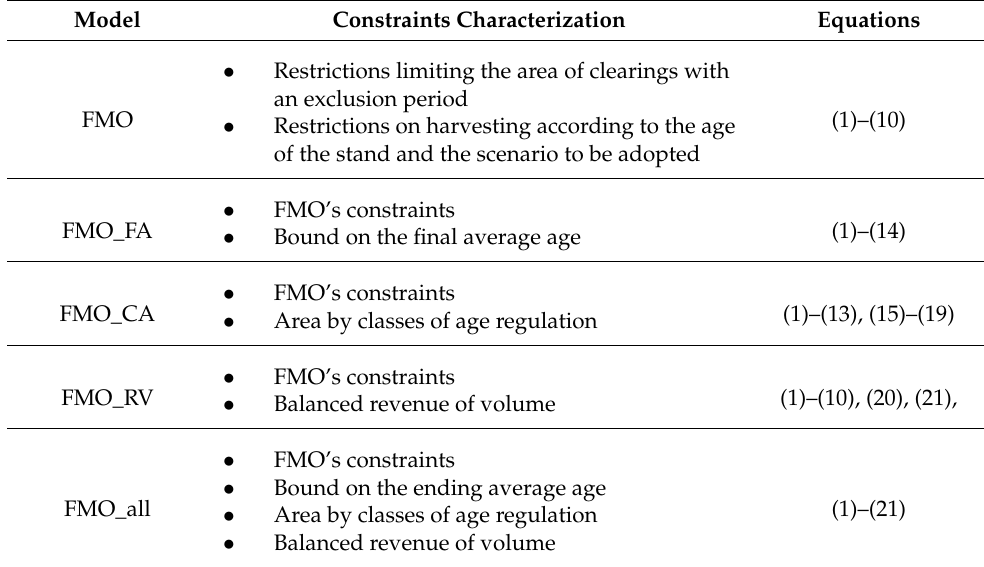
Table 2. Mathematical models’